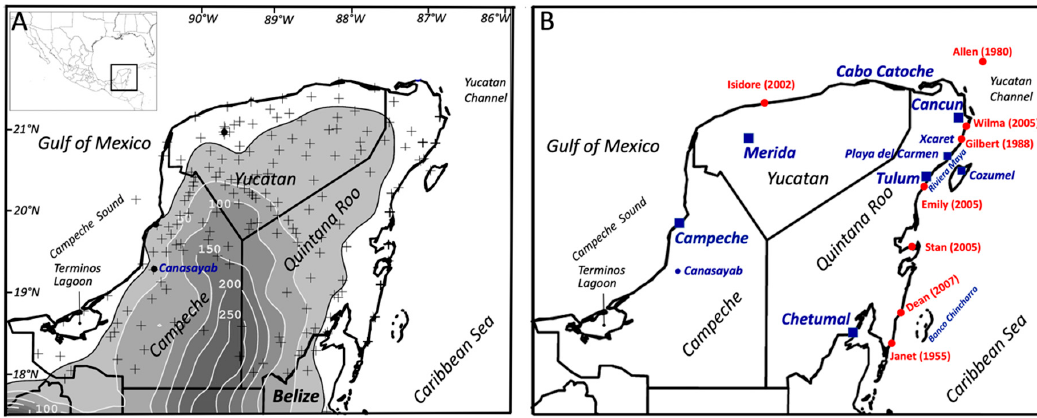
Figure 1. ( A ) Yucatan Peninsula (YP) topography. Shaded gray colors indicate relative elevations above 15 m; 50–250 m contours lines are shown in white color; plus signs are locations of 166 meteorological stations used in the computation of rainfall accumulation during tropical cyclone development over the YP; inset shows the YP location in Mexico, the Gulf of Mexico, and Caribbean Sea. ( B ) Red dots mark landfall positions for a selection of tropical cyclones from 1980–2007 and blue squares / circle are urban locations mentioned in the text.